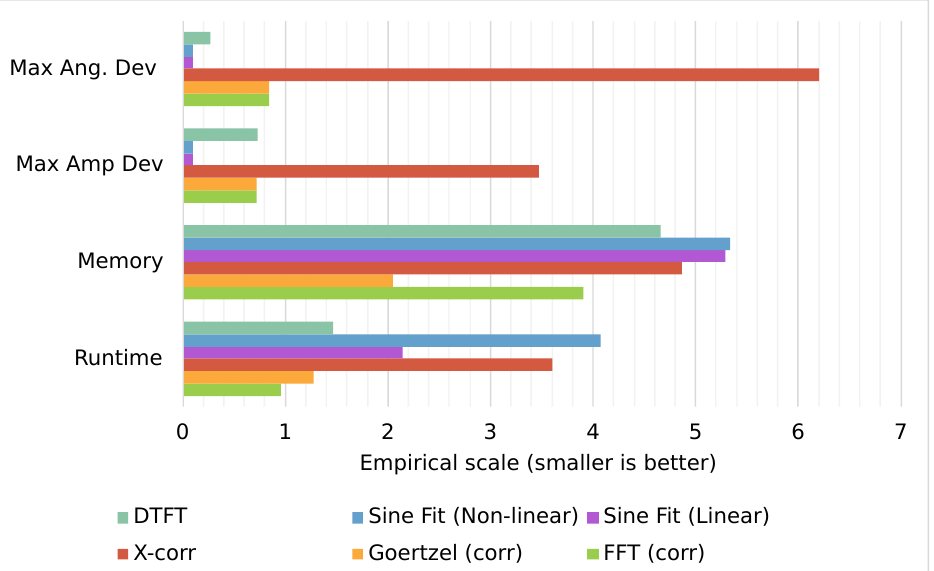
Figure 8. Methods comparison for implementation on a STM32 microcontroller with hardware